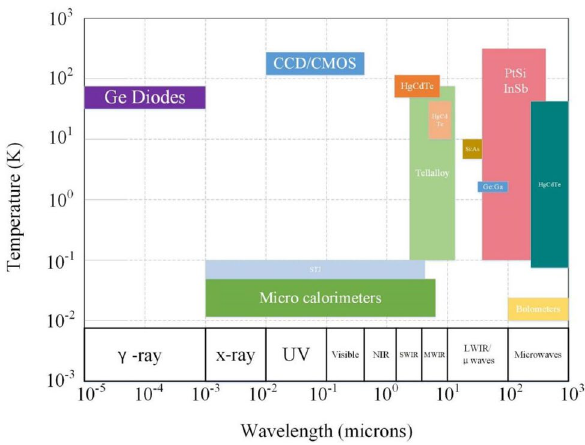
Figure 2. Common radiation detection types, wavelengths and operating temperatures 3 (generated by